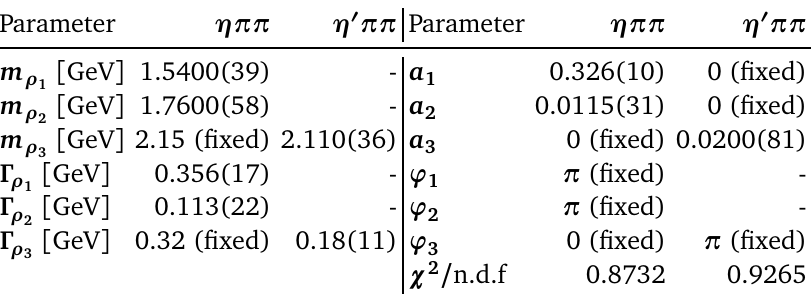
Table 4: Fit values for the ηππ and η (cid:48) ππ